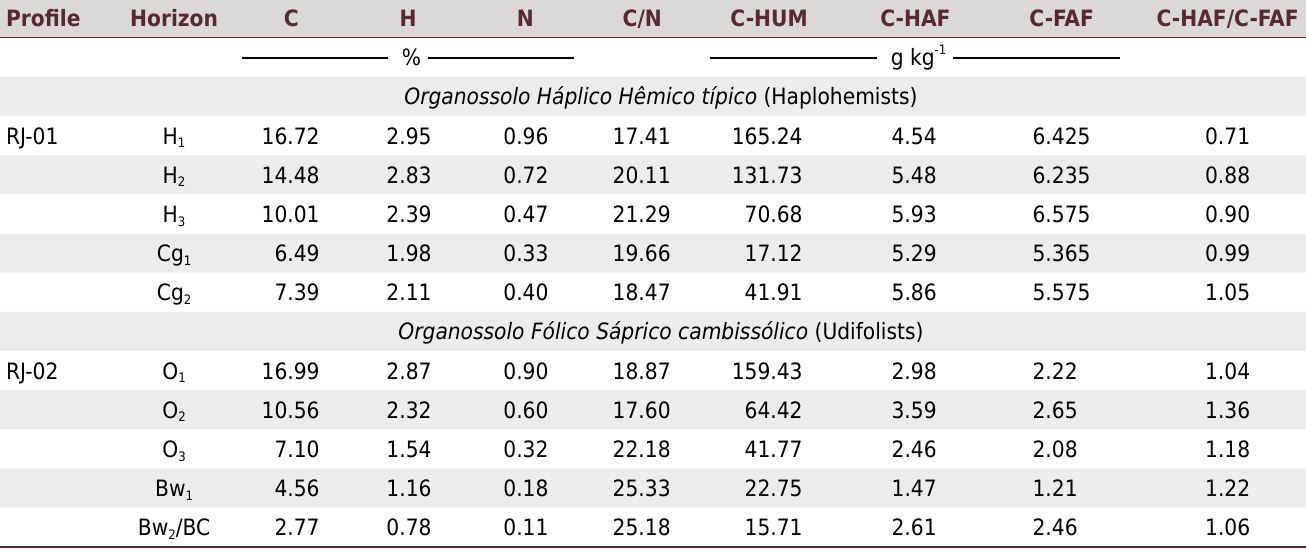
Table 4. Carbon (C), hydrogen (H) and nitrogen (N) values, C/N ratio, C levels in the humic substances, and ratio of alkaline extract C-HAF/C-FAF in an upper montane environment in Organossolos of the Itatiaia National Park, RJ, Brazil Profile Horizon